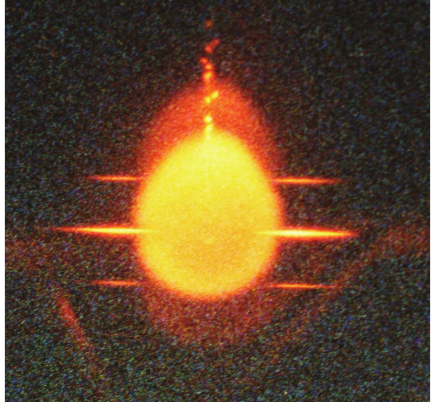
Figure 2: Digitized frame of 16mm film from the flame view